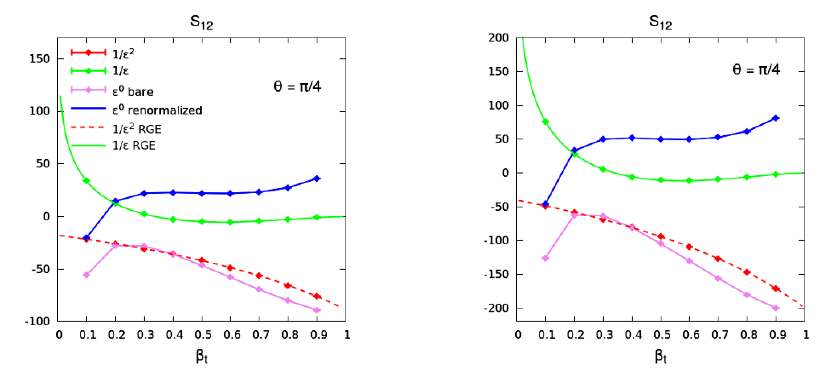
Figure 18 . Imaginary part of the NNLO soft function in the q (cid:22) q channel (left) and in the gg channel (right). The (cid:12)gures show the only one independent structure in each matrix. All details as in (cid:12)gure